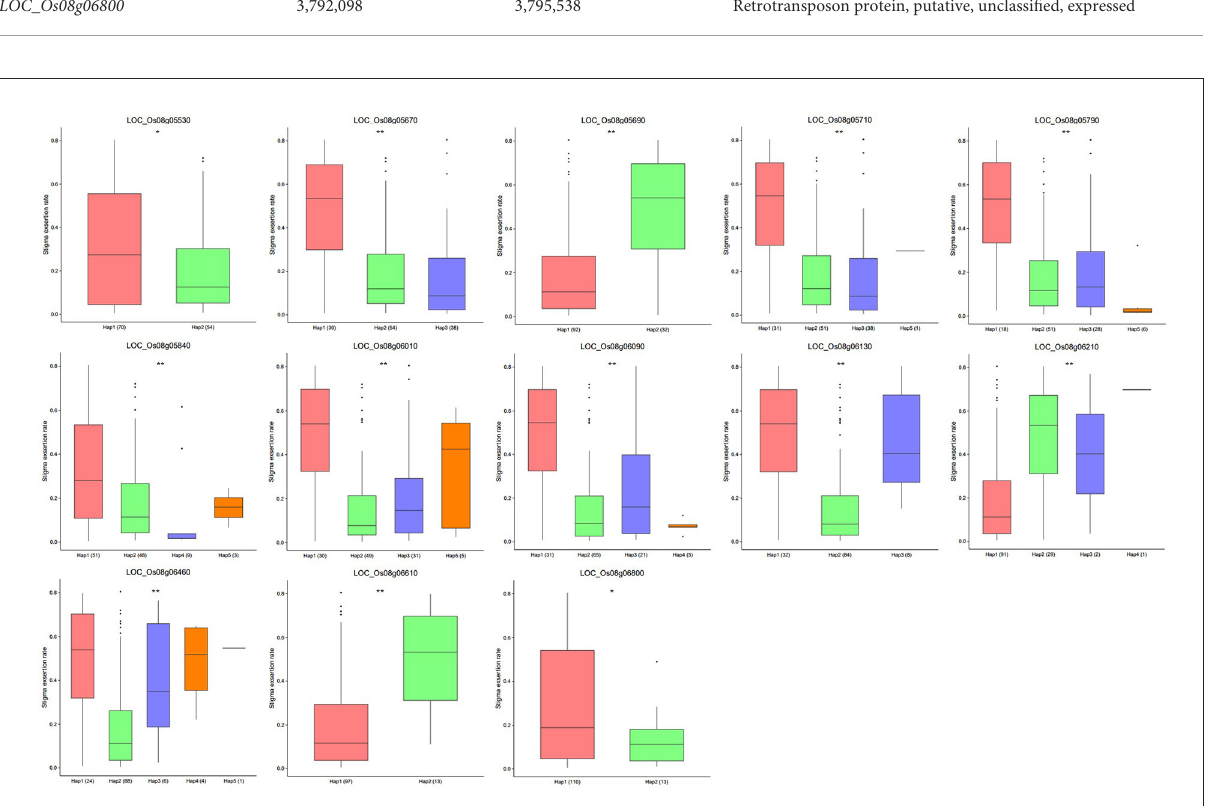
FIGURE3 Haplotype analysis of the candidate genes. * p < 0.05; ** p < 0.01; Student’s t